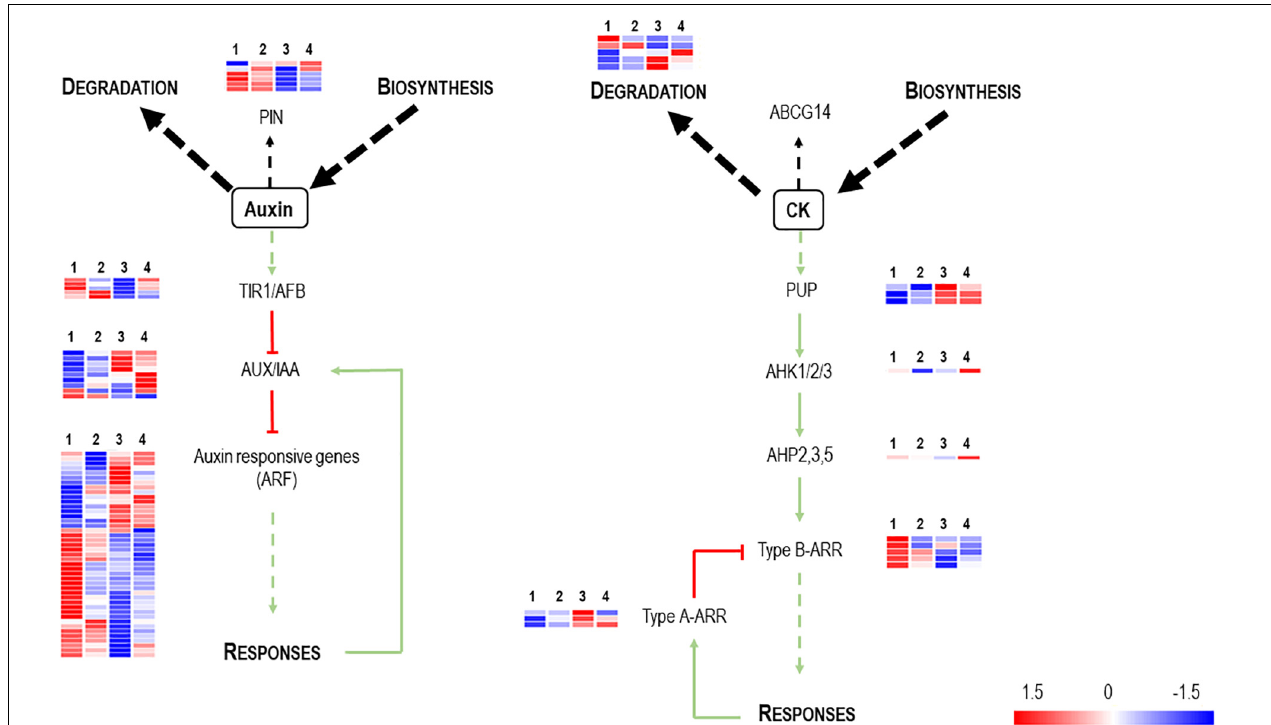
FIGURE 3 | Schematic representation of auxin and cytokinin metabolism, transport and signaling pathways (adapted from Schaller et al., 2015). PIN and ABCG14 are efflux carriers which transport auxin and cytokinin, respectively, throughout the plant. Auxins binds TIR1 receptors with induces the degradation of the AUX/IAA complex, which are transcriptional repressors of the Auxin Response Factors (ARFs). This induces the relieve of the repression of the ARFs and thus the activation of the expression of auxin related genes. In the case of cytokinin signaling, three components are involved: cytokinin receptors, AHKs; their downstream targets, AHPs; which activates the ARRs. There exist two categories of ARR (types A and B). Type-B ARRs positively control the response to cytokinin and type-A ARRs negatively regulate cytokinin signaling. The heatmaps represent the expression profiles of the identified DEGs associated to these gene functions. The color key represents the log2 relative gene expression values, red for upregulated genes and blue for downregulated genes. Each line represents one gene, and each column represents one condition (1 st column, NINi; 2 nd column, INi; 3 rd column, IVPP; 4 th column,